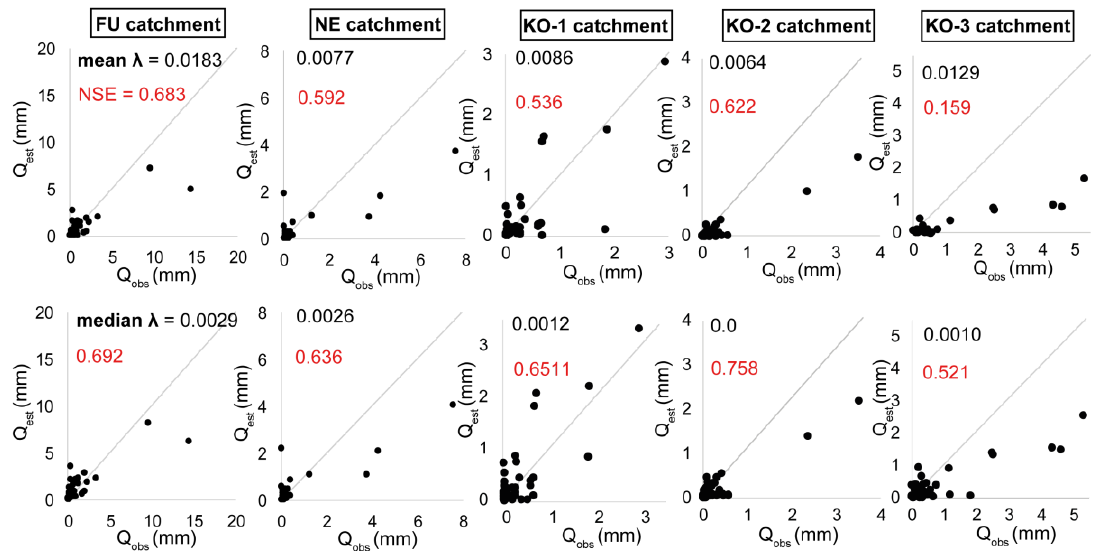
Figure 6. Comparison of observed direct runoff heights with those simulated in the experimental catchments using regressions of S according to P 10d (event analysis) with application of mean and median λ .